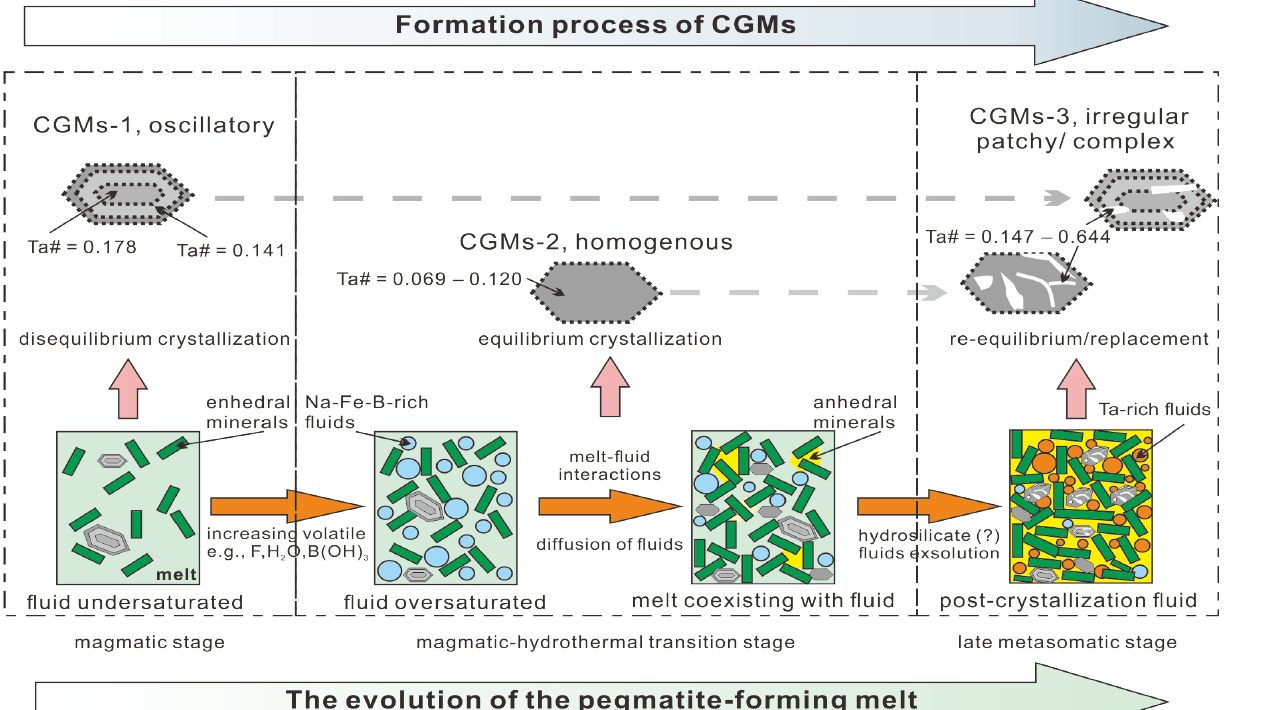
Figure 9. Schematic model illustrating the formation process of CGMs and the evolution of peg- matite. Ta# = Ta/(Ta + Nb). Note that the sizes of minerals are not to scale. Ta# = Ta/(Ta + Nb). Note that the sizes of minerals are not to